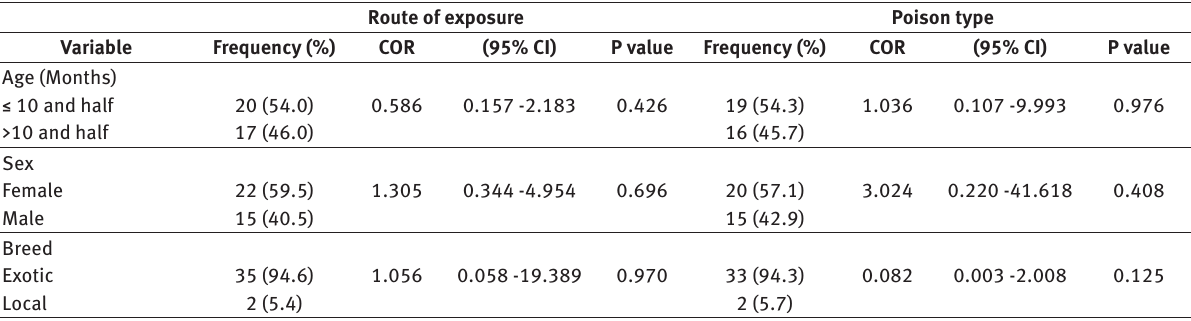
Table 2 Binary logistic regression analysis outcome for potential factors associated with route of exposure and poison type in dogs presented to the Veterinary Teaching Hospital, Federal University of Agriculture, Abeokuta, Ogun State, Nigeria with suspected cases of